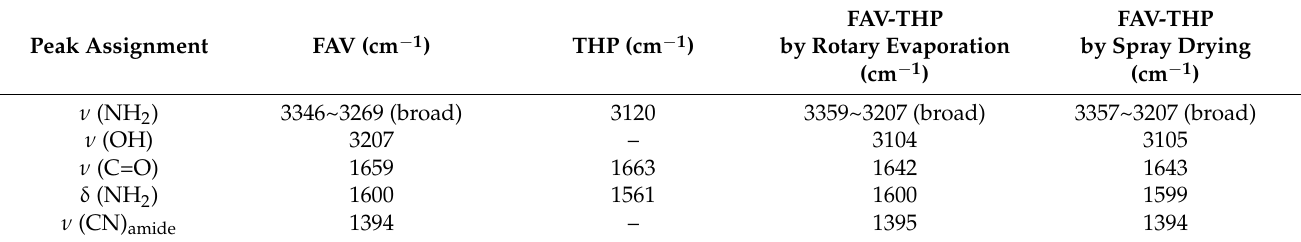
Table 3. Overview of the combinations of the material attribute and process parameters